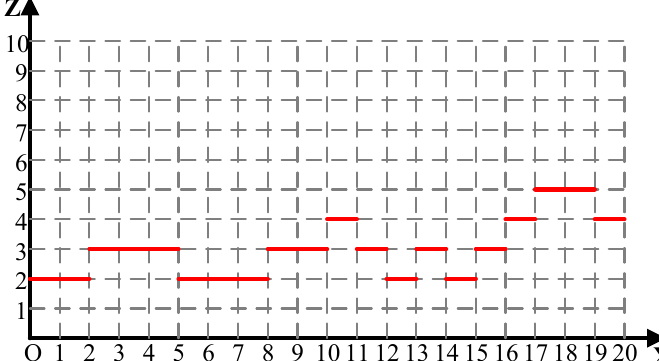
Figure 9. Elevation of candidate points.